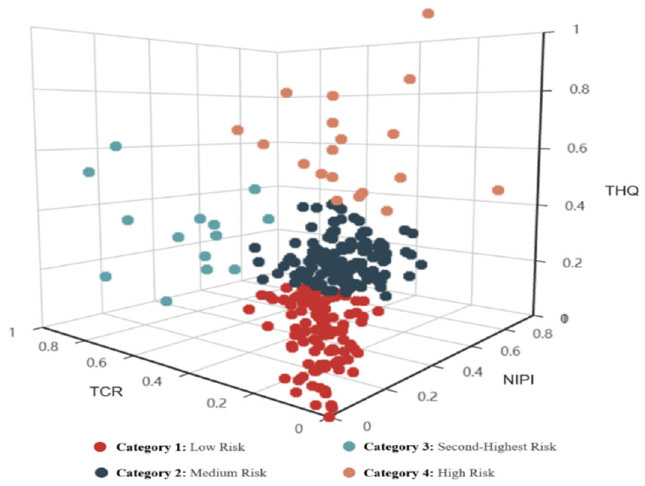
Figure 9. K-means++ clustering results.